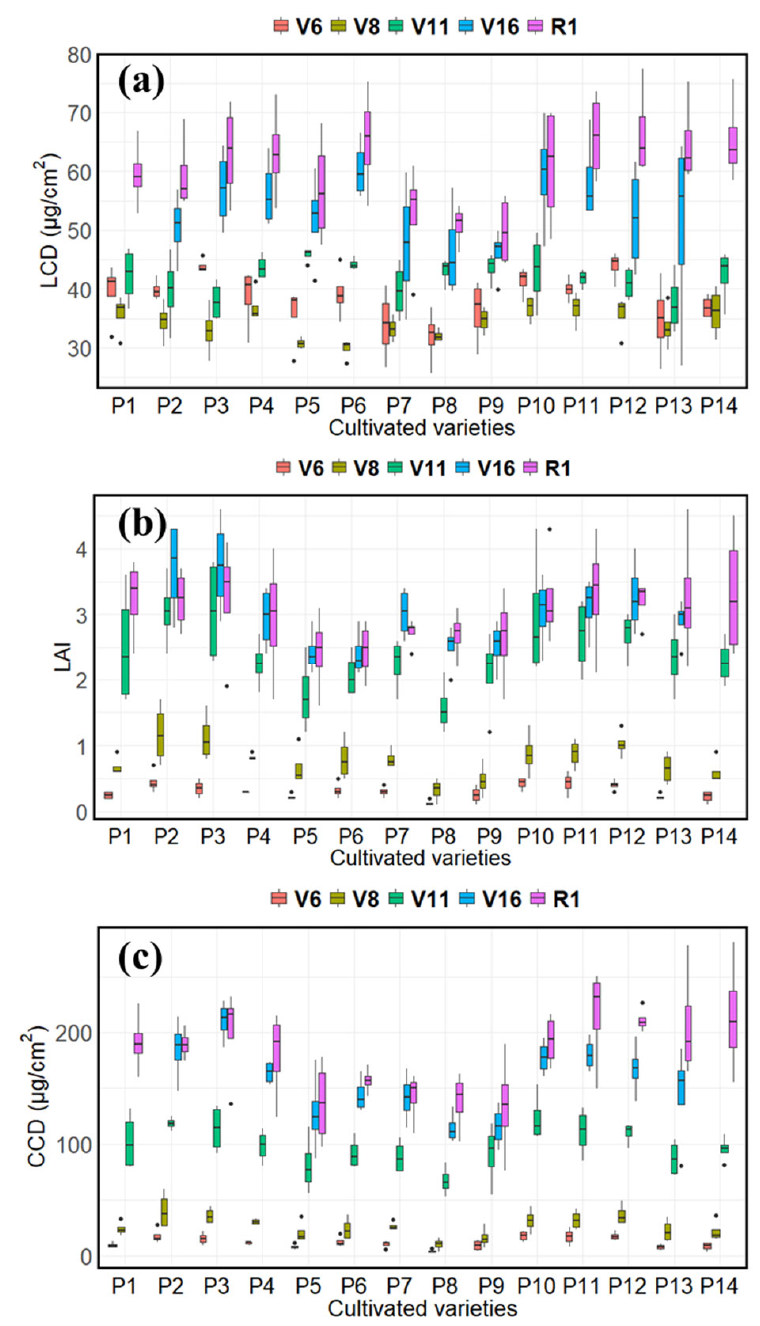
Figure 6. Box plot of ground measured data varying with variety. ( a – c ) represent distribution of LCD, LAI, and CCD along with the growth stage and 14 varieties respectively. The P1, P2, P3, P4, P5, P6, P7, P8, P9, P10, P11, P12, P13, and P14 represent the 14 varieties, respectively.